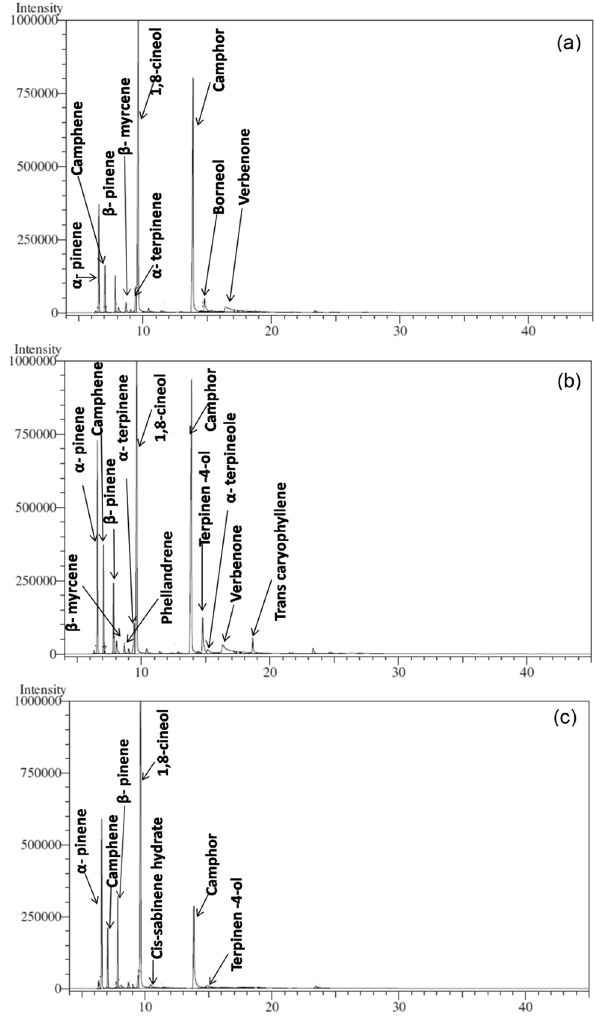
Figure 2. MS chromatograms of R. officinalis accession IHBT/RM/Ac-2 in ( a ) rainy season, ( b ) autumn season, and ( c ) summer